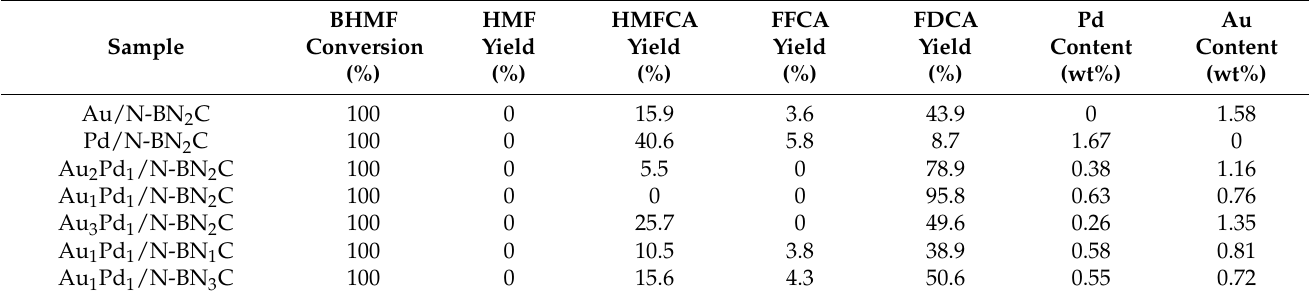
Table 2. Catalytic activity in the aerobic oxidation of BHMF by different Au m Pd n /N-BN x C nanocata- lysts and the Au/Pd content of Au m Pd n /N-BN x C.